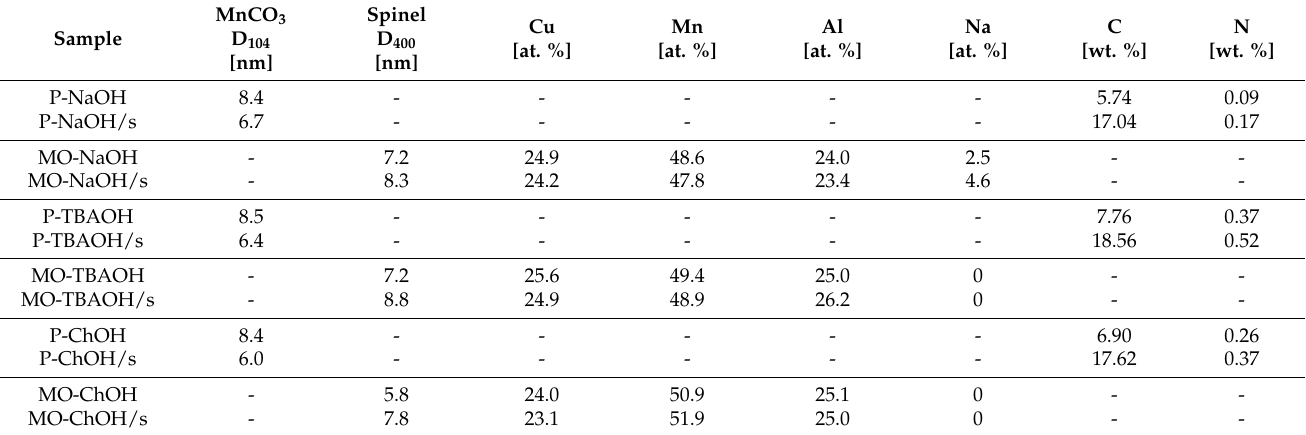
Table 1. Physicochemical parameters of synthesized solids: crystal sizes of rhodochrosite component in precursors (D 104 ) and the spinel phase in calcined mixed oxides (D 400 ). Also displayed: Cu, Mn, Al, and Na content in calcined mixed oxides, and C and N content in the